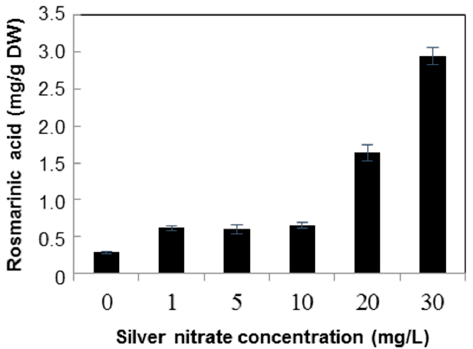
Figure 7. Contents of rosmarinic acid in Agastache rugosa callus treated with various concentrations of silver nitrate for 72 h. The levels of rosmarinic acid in each sample were analyzed by HPLC. Error bars show standard deviation values. DW, dry weight.